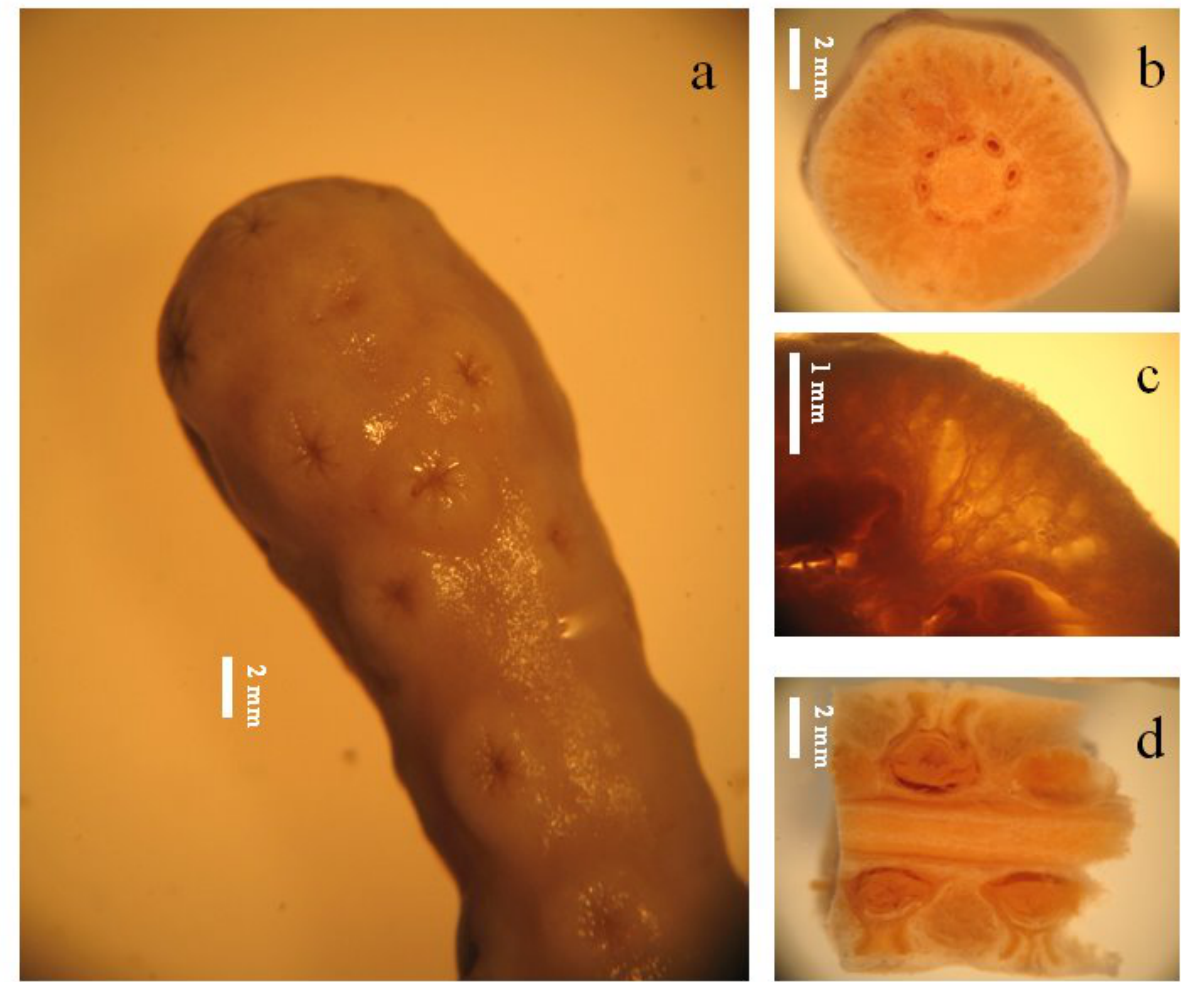
Figure 2 . Tripalea clavaria (Studer, 1878) (DOCEAN-CNI 101): a, colony; b, cross section with longitudinal canals; c, detail of lacunar inner cortex; d, longitudinal section with retracting